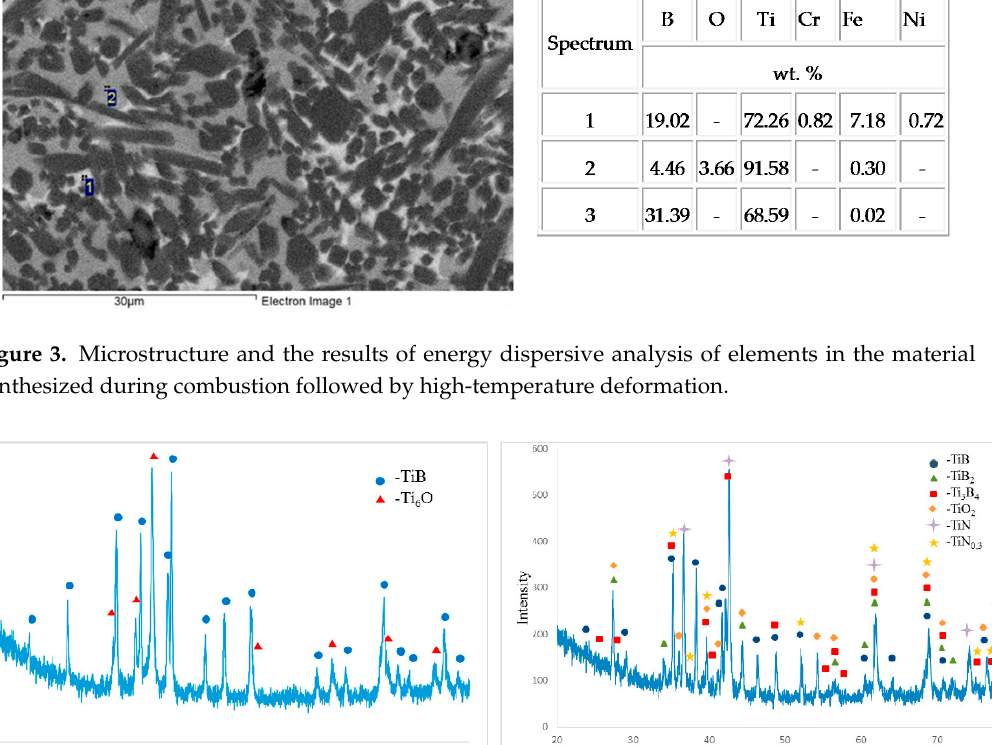
Figure 4. Results of X-ray diffraction (XRD) analysis of the ceramic materials synthesized by combustion during ( a ) self-propagating high-temperature synthesis (SHS) followed by high-temperature deformation (SHS extrusion) and ( b ) SHS.